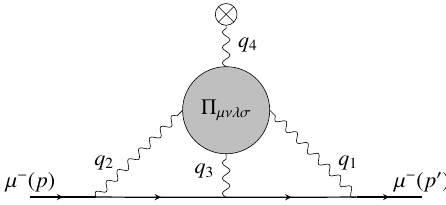
Figure 1. The HLbL diagram. The blob represent the HLbL tensor.